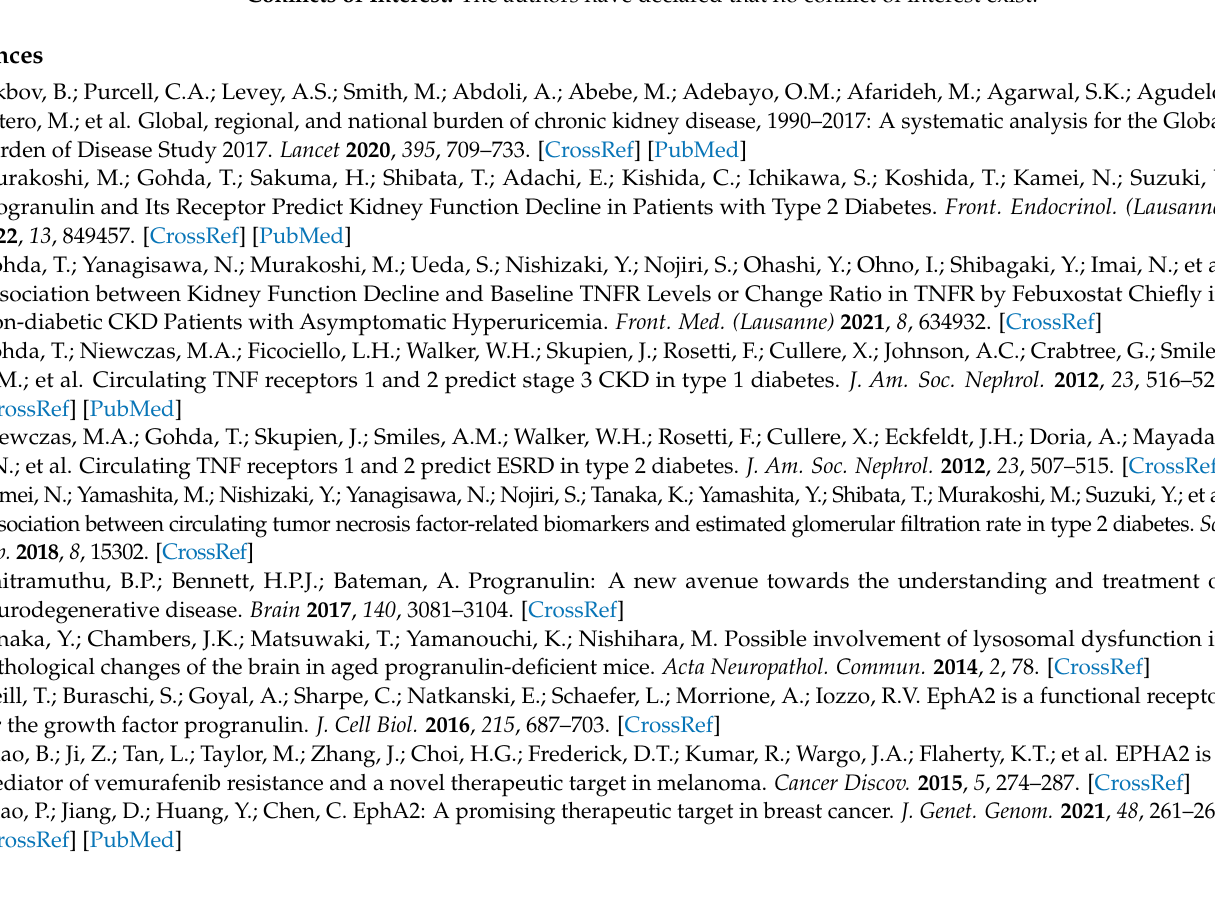
Table S2: Dilution linearity test; Figure S3: Linearity. Dilution linearity of EphA2 was assessed with two-, four-, eight- and 16-fold dilutions; Table S3: Precision test; Figure S4: The correlation of EphA2 results between the assays performed with the in-house ELISA and ELISA kit from Thermo Fisher Scientific; Table S4: Comparison of novel in-house EphA2 ELISA with a Thermo Fisher Scientific ELISA in the study